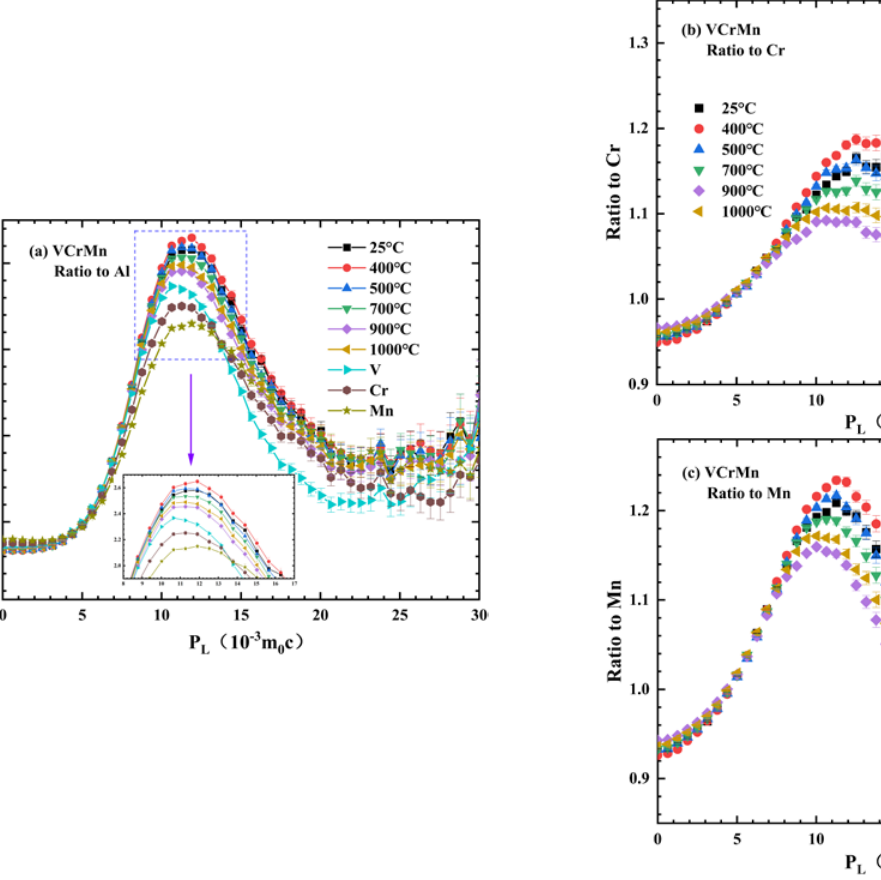
Figure 4. CDB ratio curves of V − Cr − Mn annealed at different temperatures to ( a ) pure Al, ( b ) pure Cr, and ( c ) pure Mn.